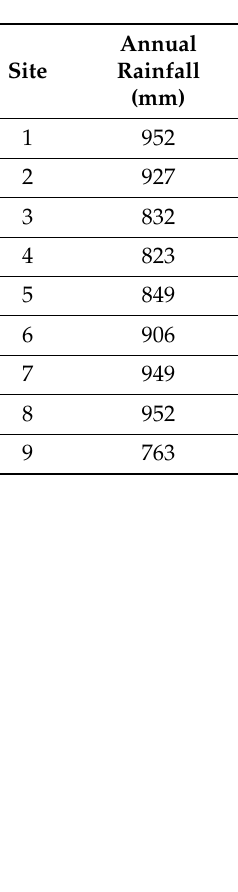
Table 1. Site data for SilviScan and Resi analysis.